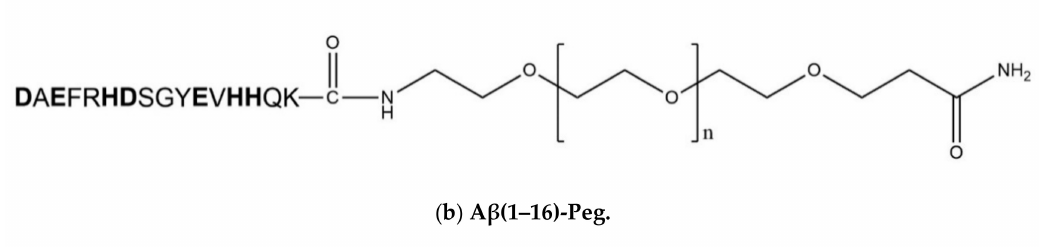
Figure 1. Aminoacid sequence of A β (1–42) ( a ) and schematic representation of A β (1–16)-PEG ( b